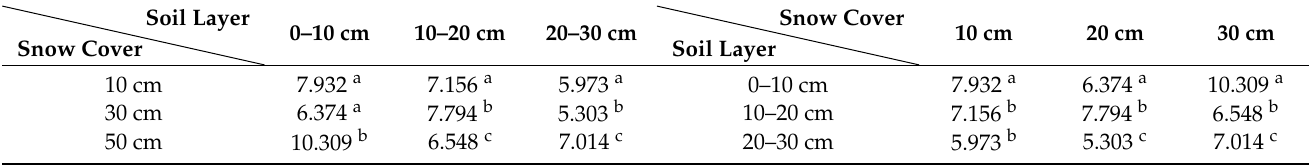
Table 8. Analysis of variance of the contribution of the snow cover to the soil water ( α = 0.05). CoverSoil Layer Snow